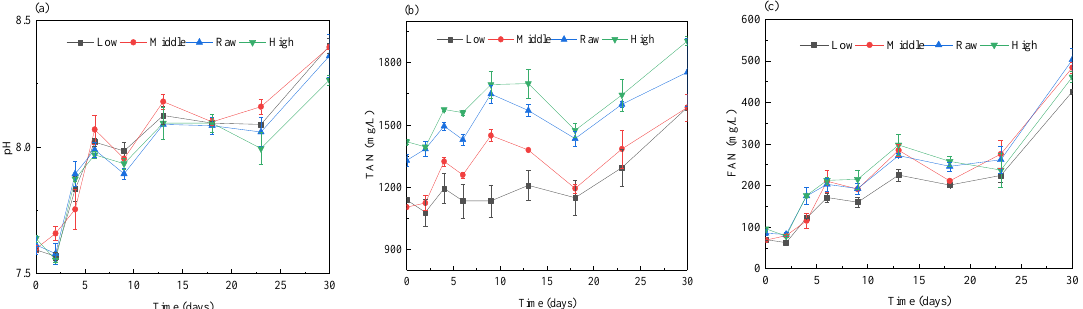
Figure 6. Variations of pH, TAN, and FAN with different blackwater BW initial TAN concentrations (Low, Middle, Raw, and High represent the BW initial TAN concentration are 1541, 2388, 4488, and 6318 mg/L, respectively): ( a ) pH, ( b ) TAN, and ( c ) FAN.